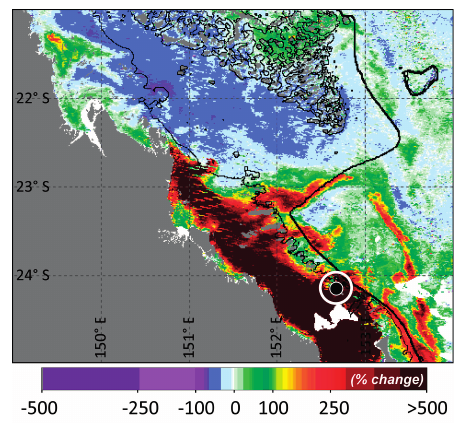
Figure A1. Transformed (100 × (Observed − Climatology)/Climatology) MODIS chlorophyll- a (mg·m − 3 ) image for the 2 to 4 February 2013. Climatology inclusive